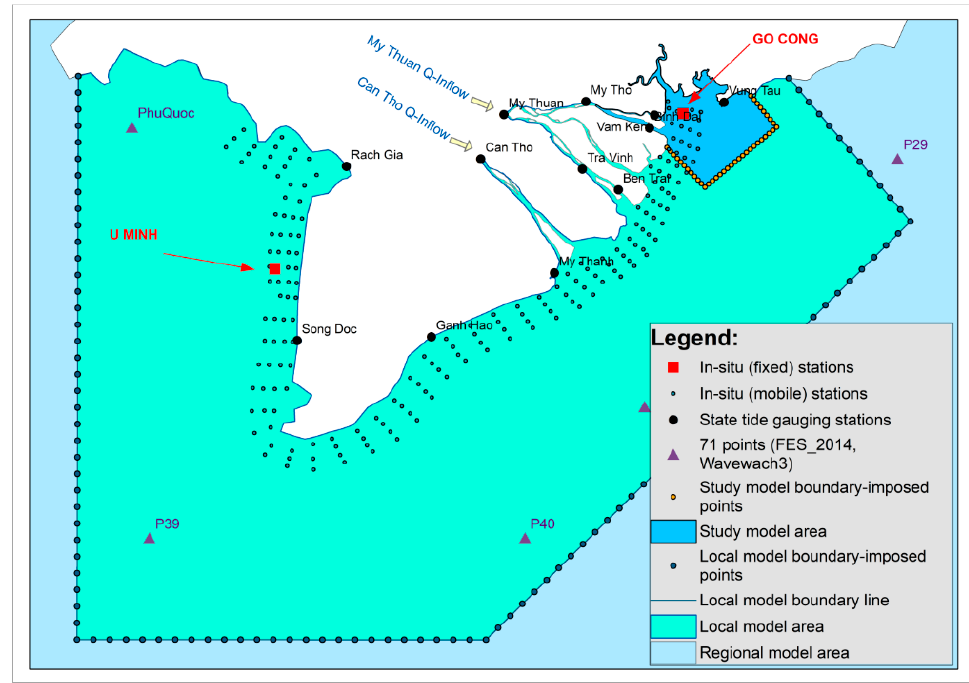
Figure 3. Stations for models’ calibration/validation.